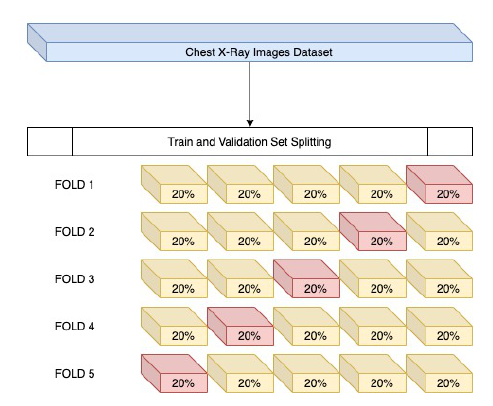
Figure 14. Cross validation.